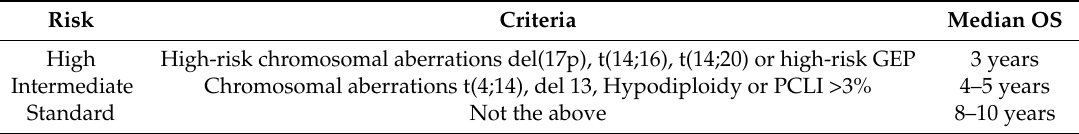
Table 3. mSMART risk stratification system